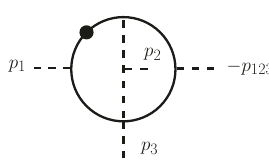
Figure 4 . The two-loop scalar Feynman corresponding to I NPL (0 ; 1 ; 1 ; 1 ; 2 ; 0 ; 1 ; 1 ;